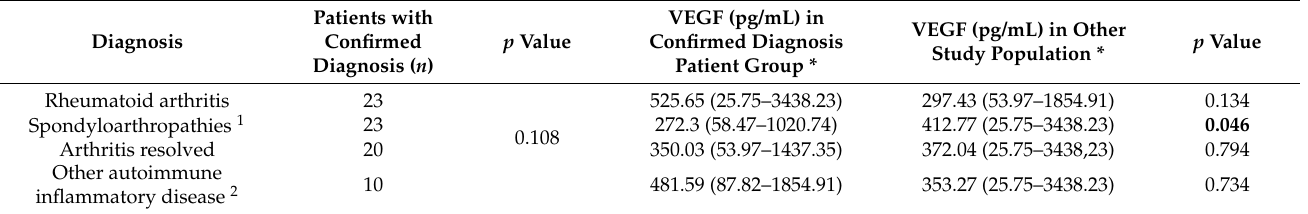
Table 9. VEGF level distribution between undifferentiated arthritis patient cohort outcomes in 12-month follow-up.